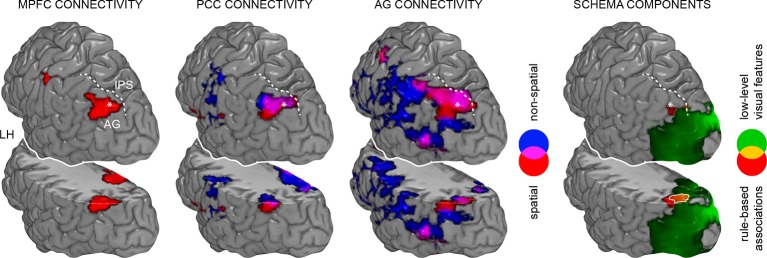
Spatial relationship between schema retrieval networks and schema component representations.Results from connectivity analyses (seeds MPFC, PCC, AG), and MVPA are shown as a 3D rendering. During schema retrieval, MPFC and PCC were functionally connected with the same AG region (left part). Furthermore, MVPA revealed distributed representations of different schema components that converged within the left AG during retrieval (right and surrounded in white). To aid orientation, dashed lines schematically indicate the intraparietal sulcus (IPS). Asterisks mark identical locations within the AG across the different methodological approaches. Additionally, we show a horizontal cut at the level of the AG to demonstrate sub-surface effects. LH – left hemisphere.